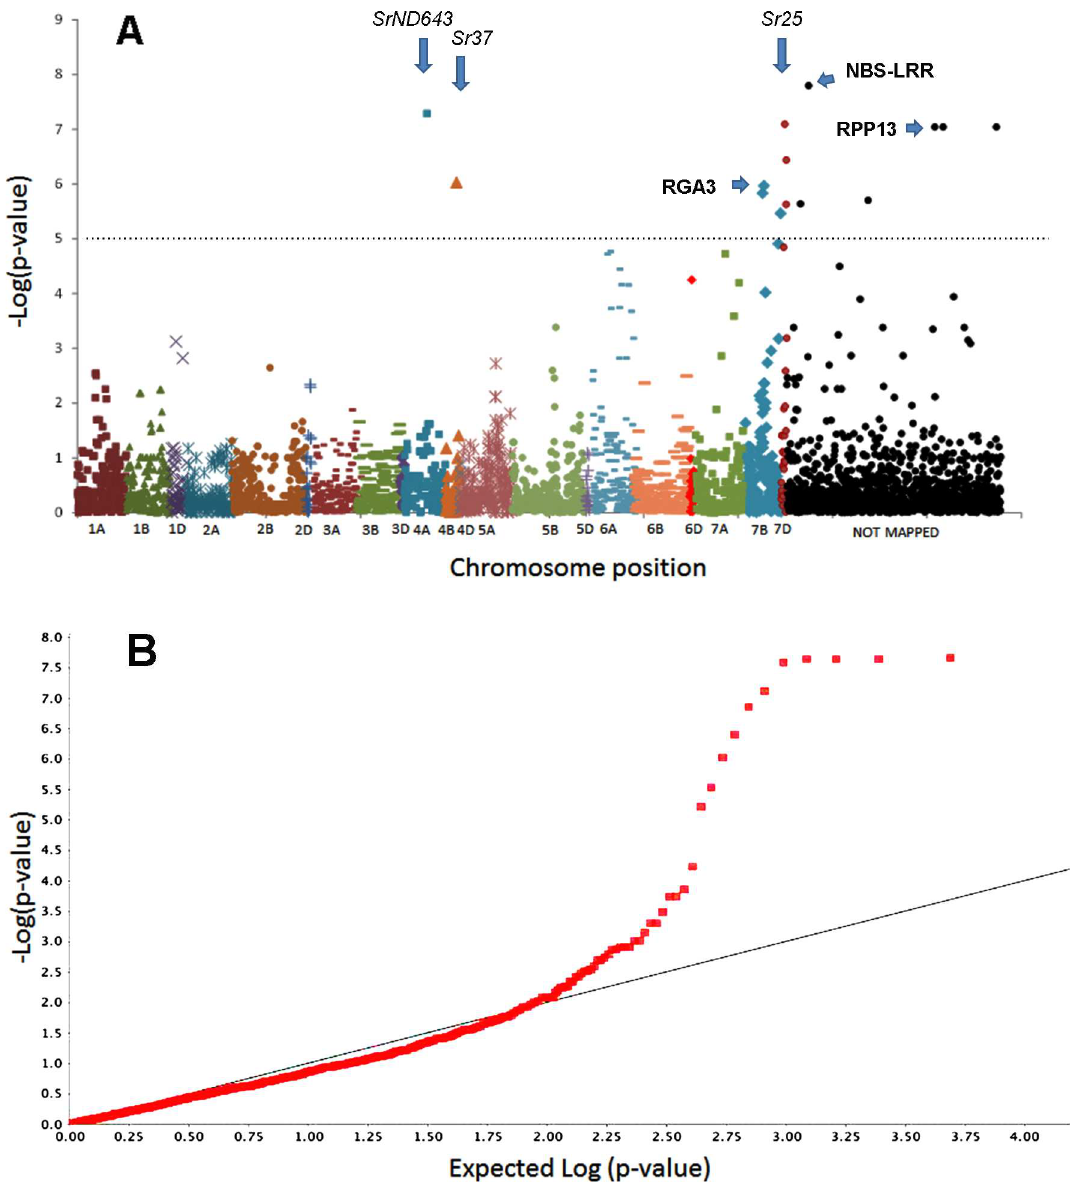
Fig 2. Manhattan and quantile-quantile (QQ) plots of association mapping of stem rust resistance in the 5 th SRRSN. A, each symbol represents a SNP. A false discoveryrate of 0.05 was used for significantassociations. Significant markers above the cutoff value of–log P = 5.0 (dotted line) were associated with SR resistanceand they were listed in Table 2. The chromosome position was basedon the 9k SNP linkagemap. Each chromosome is numbered and distinguished by a color and shapeof dots. The black dots represent unmapped markers. Arrows indicate the approximate positionof known Sr genes and putative candidate genes for Ug99 resistance. B, The result of marker-trait associationis illustrated in the QQ plot using observedagainstexpectedp-values (log transformed negatives).A mixed linear model controlled by Q and K matrices was used for